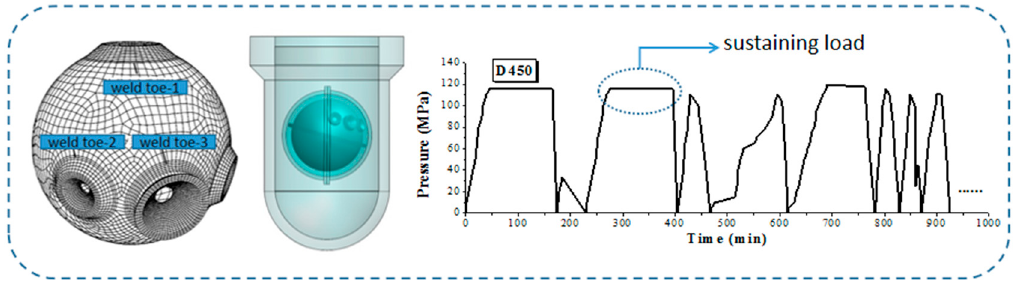
Figure 9. Loading history of the manned cabin and ultra-high-pressure chamber (UHPC, with inner diameter of 450 mm).